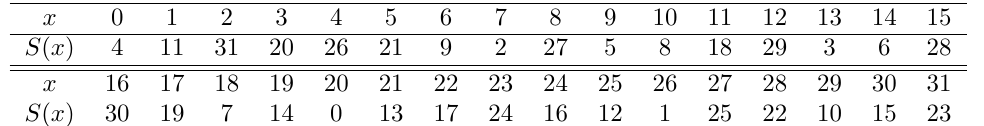
Table 3: The 5-bit S-box in the Substitution Layer of